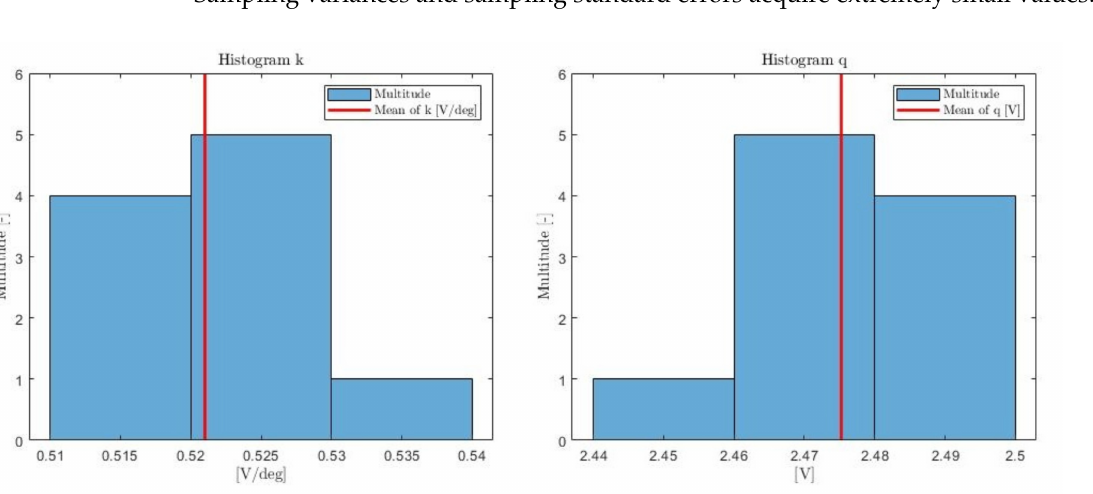
Figure 10. Histogram of k and q